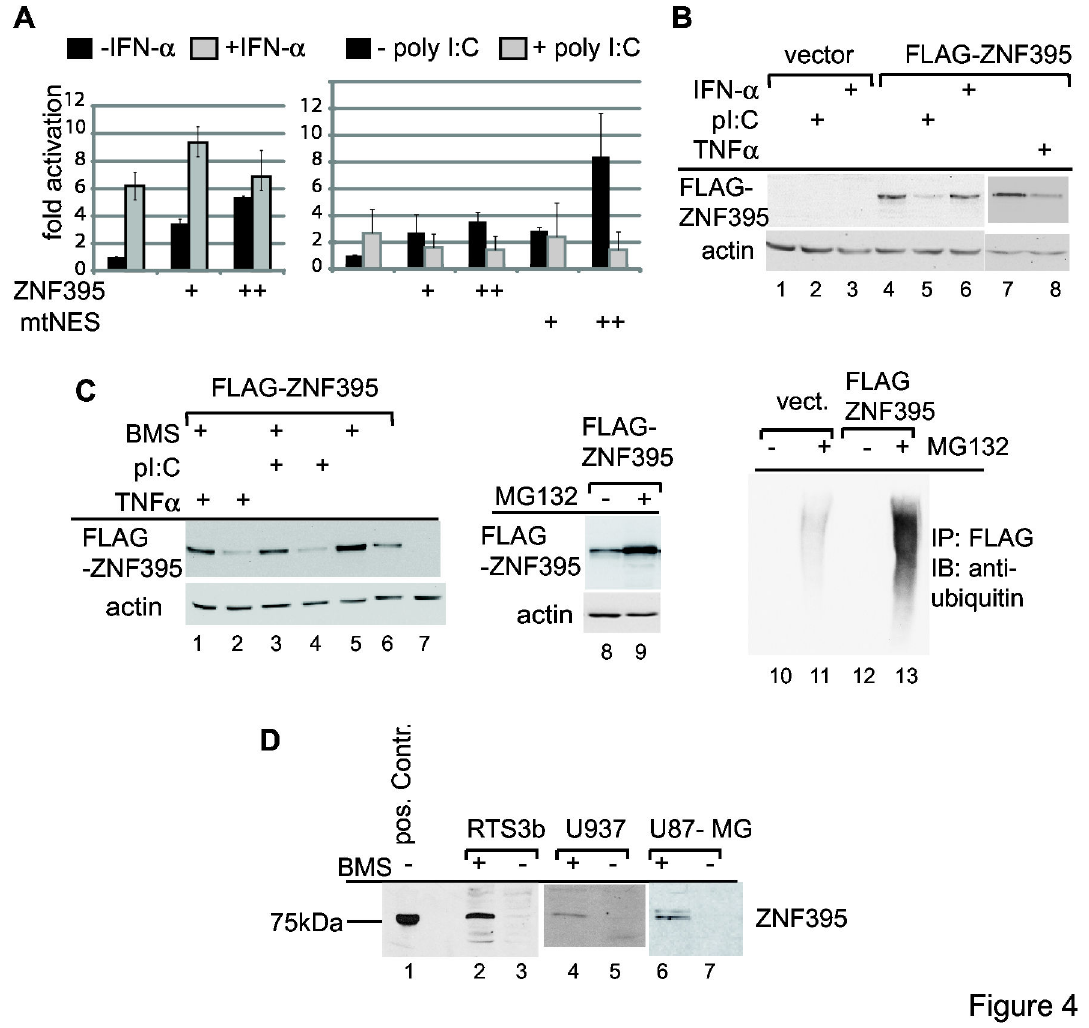
Figure 4. Active IKK marks ZNF395 for degradation. ( A ) RTS3b cells were transiently transfected with 5ng (+) and 10ng (++) of the expression vector for FLAG-ZNF395 and in the experiments shown in the right graph, 5ng (+) or 10ng (++) of the vector for ZNF395mtNES was included. The transfected cells were treated either with IFN-α (left graph) or with polyI:C (right graph) as indicated. The bars represent the fold activations calculated from three independent experiments and the standard deviations are included. ( B ) Cells were transiently transfected with expression vector for FLAG-ZNF395 (lanes 4-8) or the empty vector (lanes 1-3) and treated either with polyI:C (lanes 2, 5), IFN-α (lanes 3, 6), TNFα (lane 8) or solvent (lanes 1, 4, 7). An IB with the anti-ZNF395 antibody and the anti-actin antibody was performed. ( C ) Cells transiently transfected with the FLAG-ZNF395 vector or the empty vector (in lanes 7, 10, 11) were treated with TNFα (lanes 1, 2), poly I:C (lanes 3, 4) or MG132 (lanes 9, 11, 13). BMS-345541 was added to the cells used in lanes 1, 3, 5 and the solvent DMSO in lanes 2, 4, 6, 7, 8. The analysis of ZNF395 expression was done by IB using the anti-FLAG and anti-actin antibody. In lanes 10–13, FLAG-ZNF395 was precipitated by M2-FLAG-agarose and the IB was performed with an antibody against ubiquitin. ( D ) RTS3b (lanes 2, 3), U937 (lanes 4, 5) or U87-MG cells (lanes 6, 7) were incubated in medium containing BMS-345541 (+) or DMSO (-) and analyzed for ZNF395 expression by an IB developed with the anti-ZNF395 antibody. In lane 1, extracts prepared from RTS3b TR-FLAG-ZNF395 cells used in Figure 1 were used as a control. doi: well as IKKβ from extracts of cells that have been co- recombinant FLAG-ZNF395 (Figure 5B, lane 9), confirming the transfected with expression vectors for FLAG-ZNF395 and HA- notion that active IKK marks ZNF395 for proteasomal IKKα or HA-IKKβ, and not when the cells have been degradation. Finally, we show that ZNF395 interacts with both kinases. The FLAG antibody was able to co-precipitate IKKα as